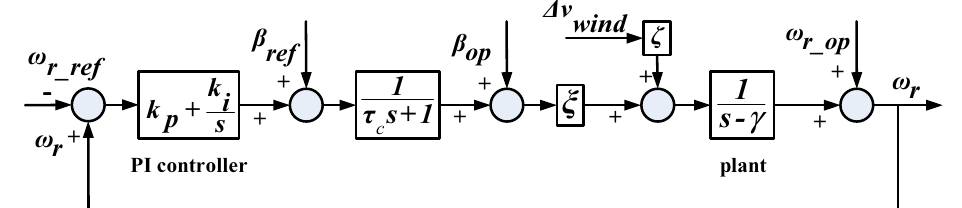
Figure 3. Block diagram of the pitch angle control